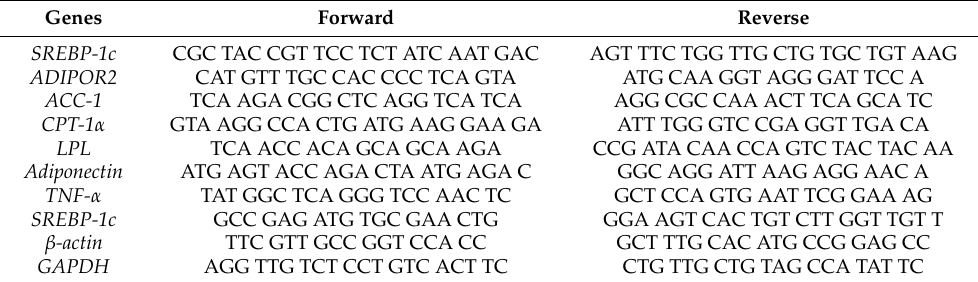
Table 2. Sequence of primers used in the RT-qPCR